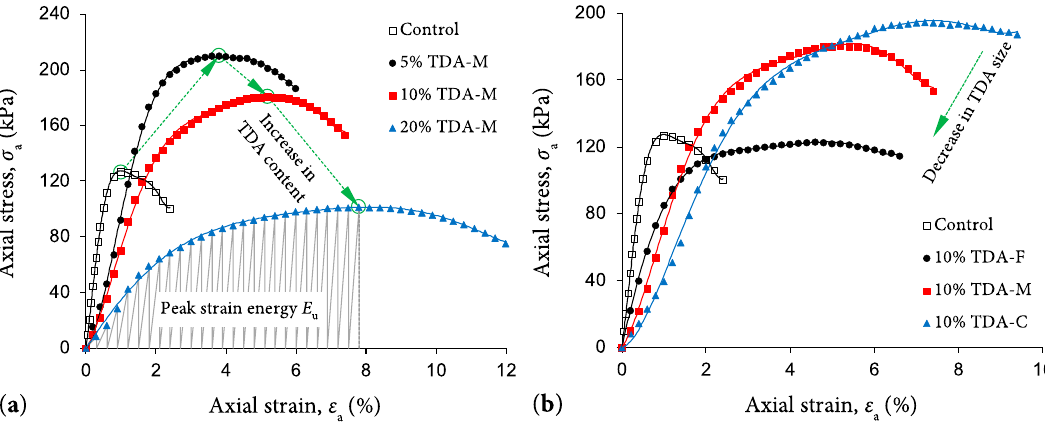
Figure 7. Typical stress–strain relationships for the unamended soil (control) and various soil–TDA blends: ( a ) TDA-M with f T = 5%, 10% and 20%; and ( b ) TDA-F, TDA-M and TDA-C with f T = 10%.